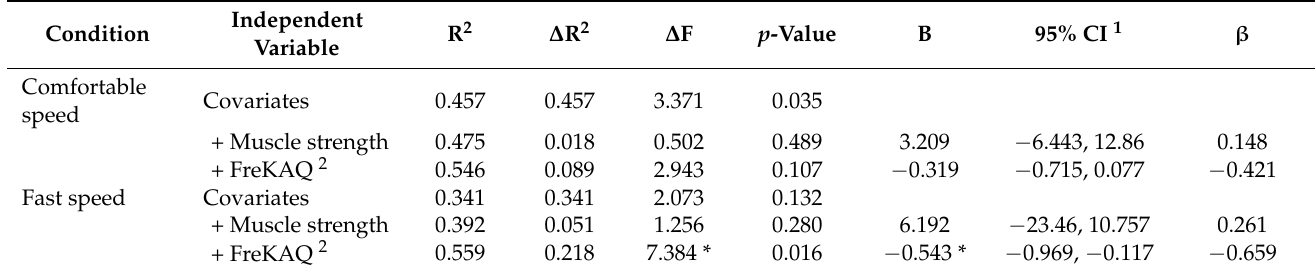
Table 5. Results of hierarchical regression analysis predicting knee flexion excursion in loading response.